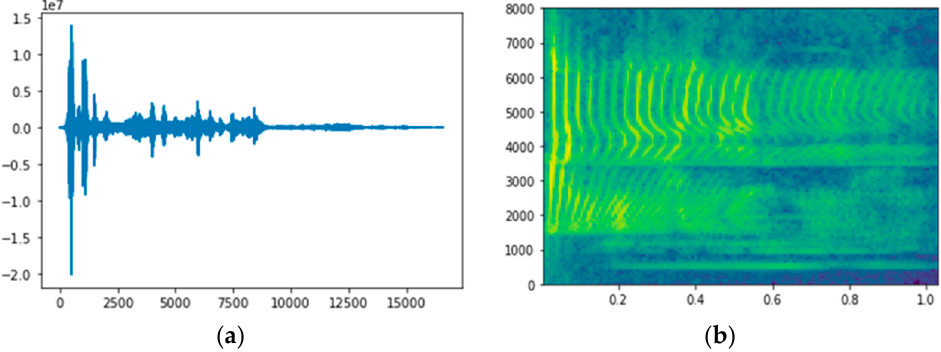
Figure 3. DFT: ( a ) change in frequency range within time domain and ( b ) spectrogram. Two-dimensional (2D) signals were used for spectral analysis in the experiments. The